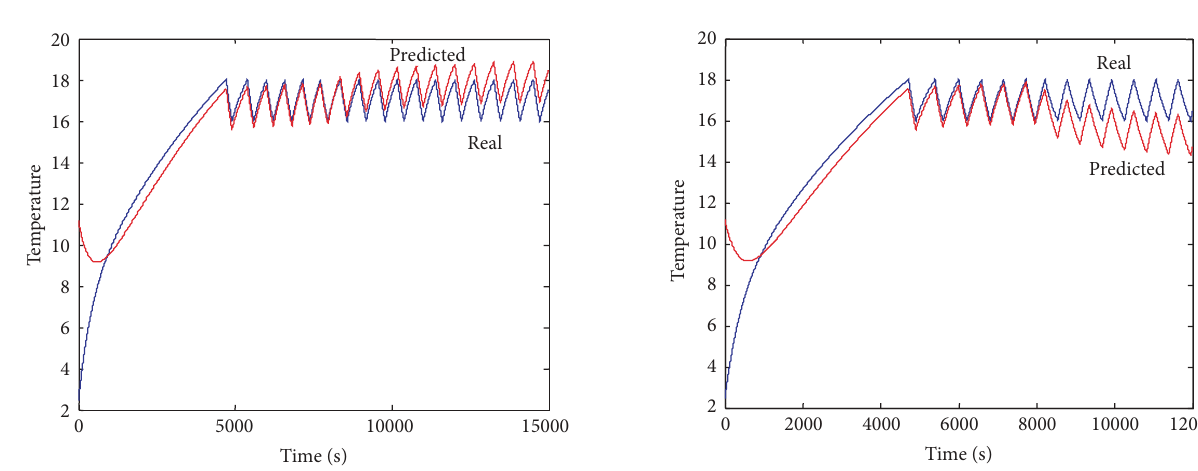
Figure 9: Real and predicted temperature of zone I, with a heat leakage starting at 𝑛 = 8000 .